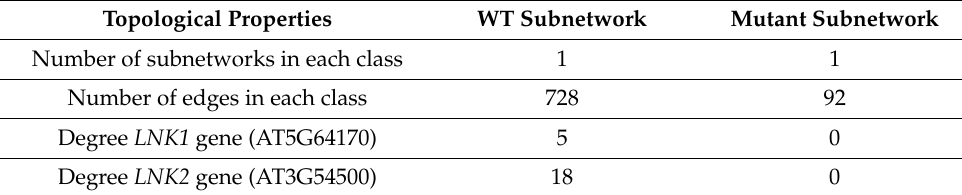
Table 1. Topological properties of wild type and mutant subnetworks.